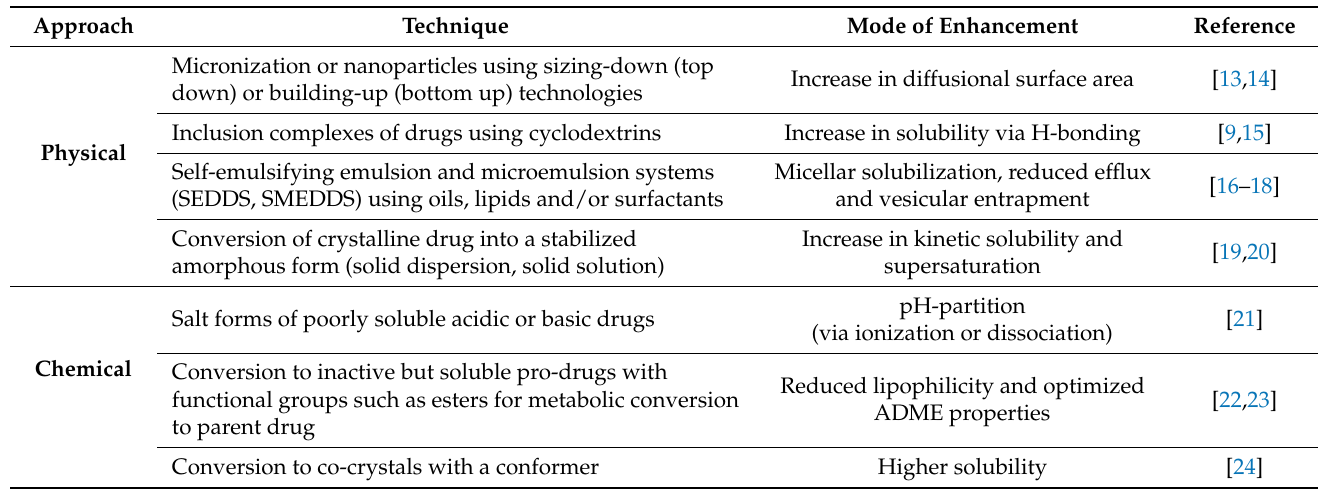
Table 1. Techniques to improve solubility and bioavailability and/or dissolution rate of poorly water soluble drugs. Approach